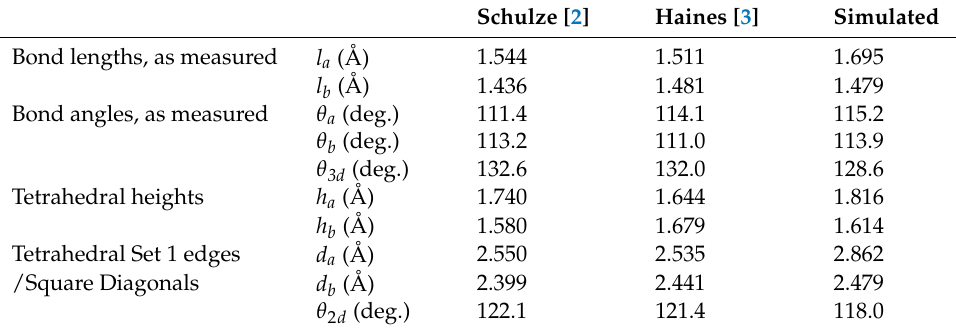
Table 2. The various experimentally/DFT obtained parameters and structural features. Parameters defined in